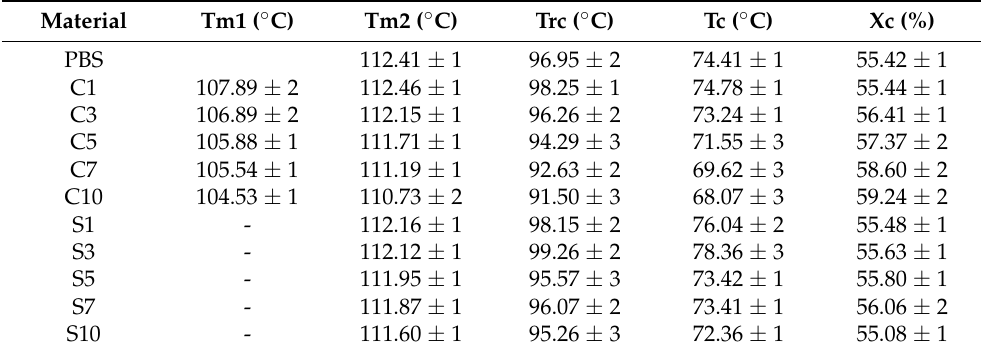
Table 5. The melting temperature (Tm), re-cooling temperature (Trc), crystallization temperature (Tc) and degree of crystallinity (Xc) of PBS and its compounds. Data are means ± standard deviations ( n = 3).